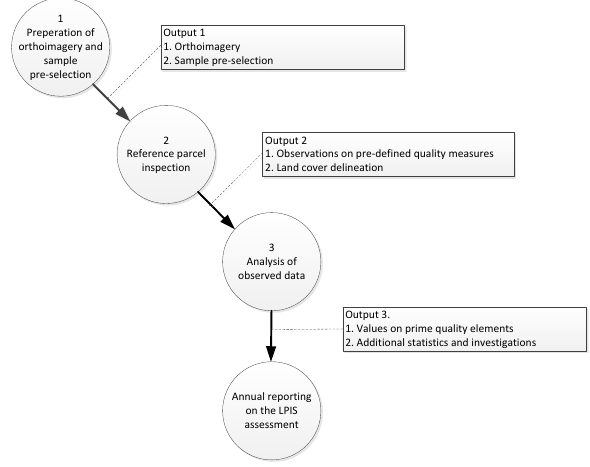
Figure 7: an overview of the different phases of the inspection of the quality of the reference layer